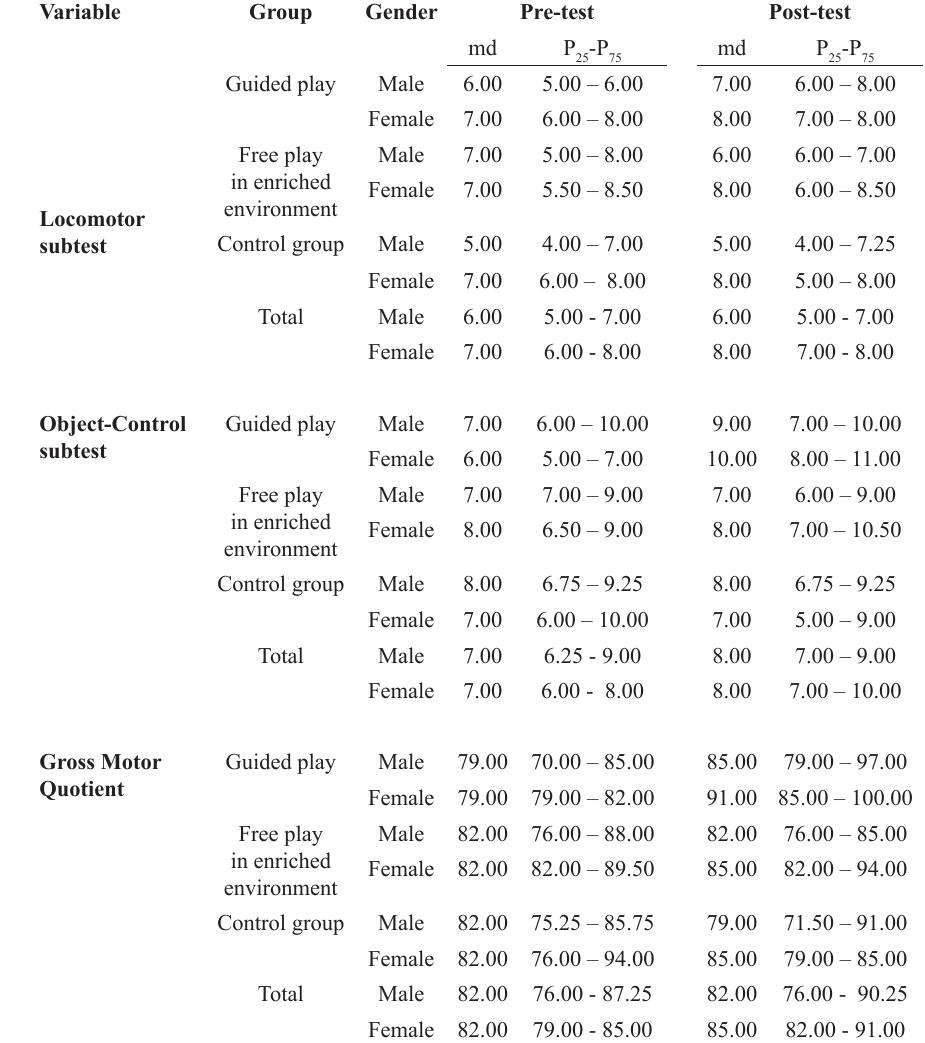
( p = 0.332), free play in enriched environment ( p = 0.599) and Table 2. Pre- and post-test locomotor and object-control raw scores and gross motor quotient by